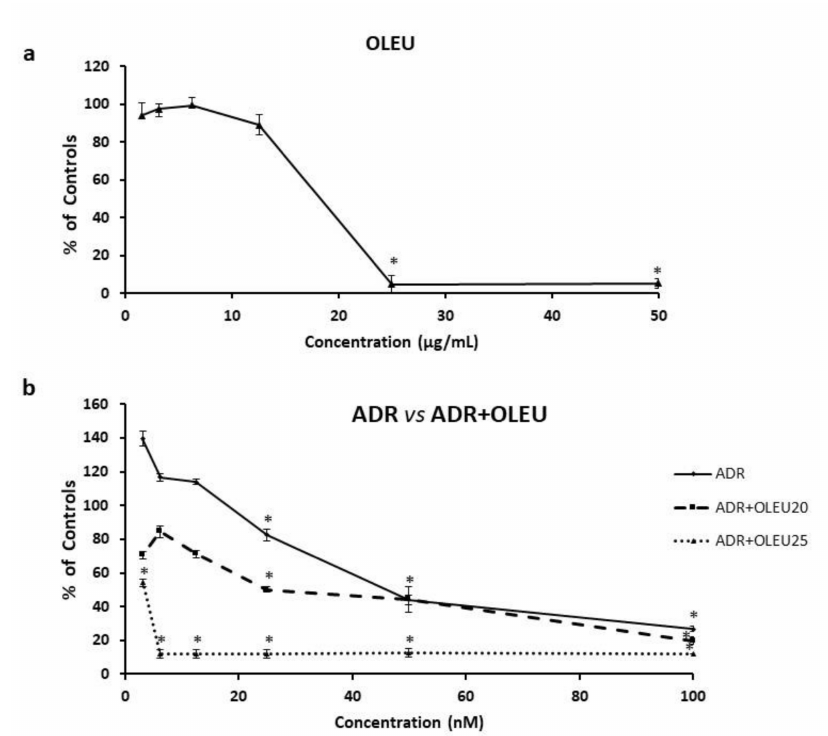
Figure 1. Dose–response curves for the continuous administration of ( a ) OLEU (Oleuropein) alone (3–50 µ g/mL) and ( b ) ADR (Adriamycin) alone and in co-treatment schemes with either 20 µ g/mL